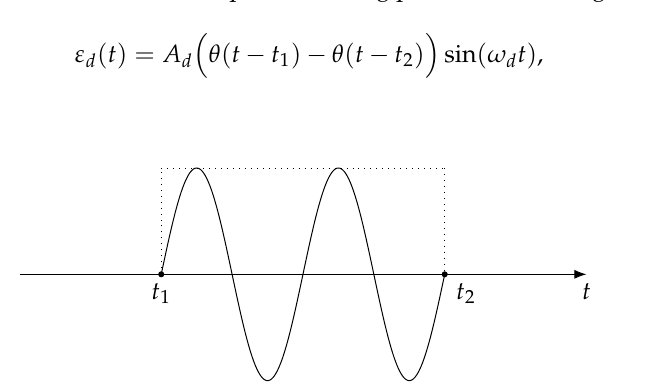
Figure 1. Rectangular-shaped dressing pulse that starts at time t 1 = 0 and ends at t 2 , which is an integer multiple of the period 2 π / ω d